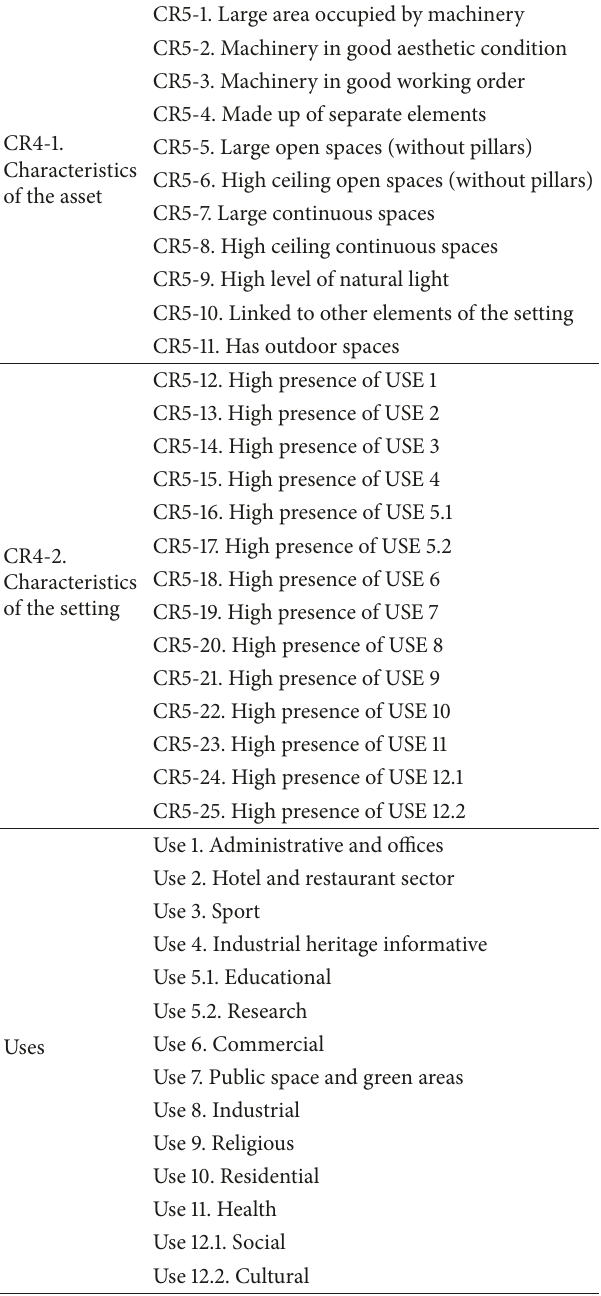
Table 4: Criteria and uses considered in the hierarchical structure to select new